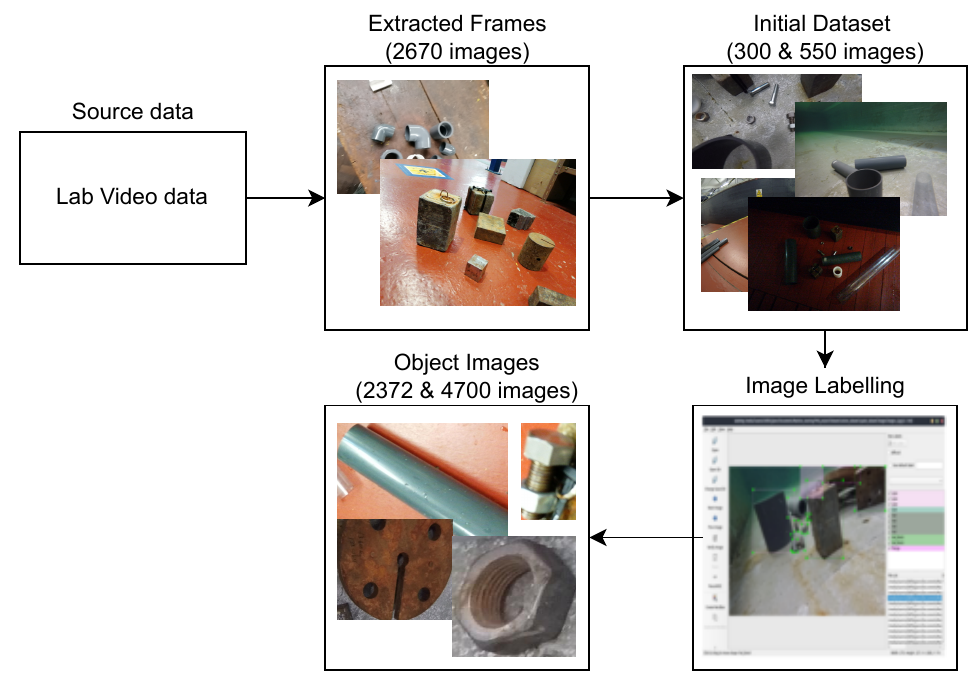
Figure 3. Data Processing